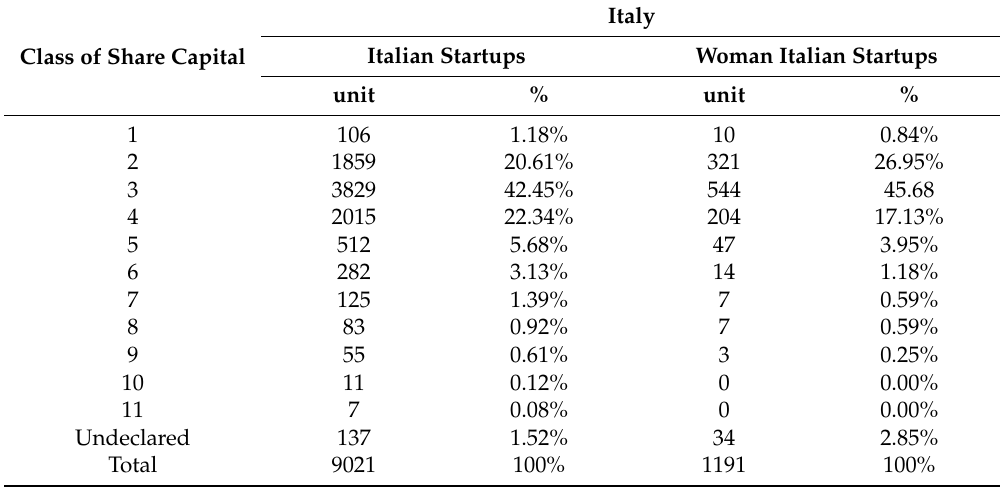
Table 3. Class of Italian startups and the Italian woman startups’ share